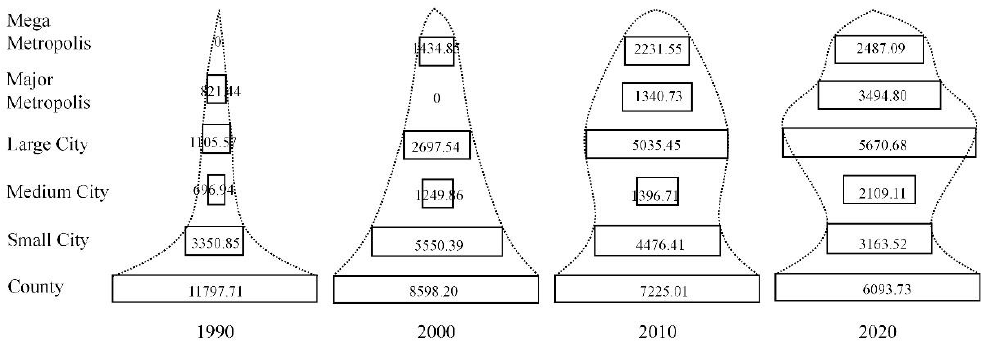
Figure 3. Total population across hierarchies from 1990 to 2020 (unit: 10,000).